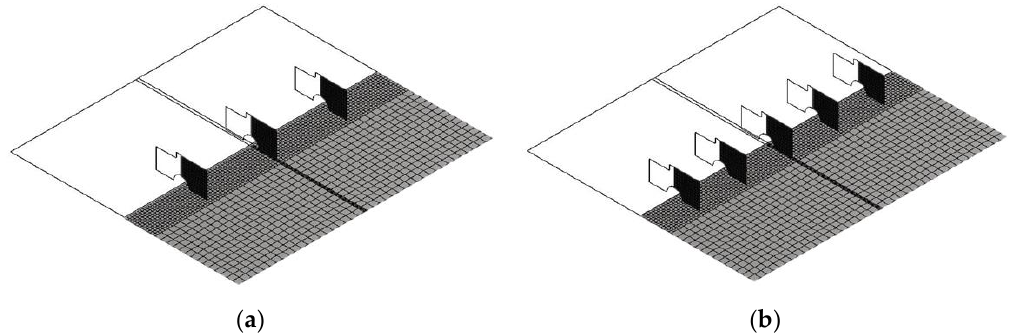
Figure 12. Symmetric finite element models including piece elements: ( a ) specimen 2 and ( b ) specimen 3.